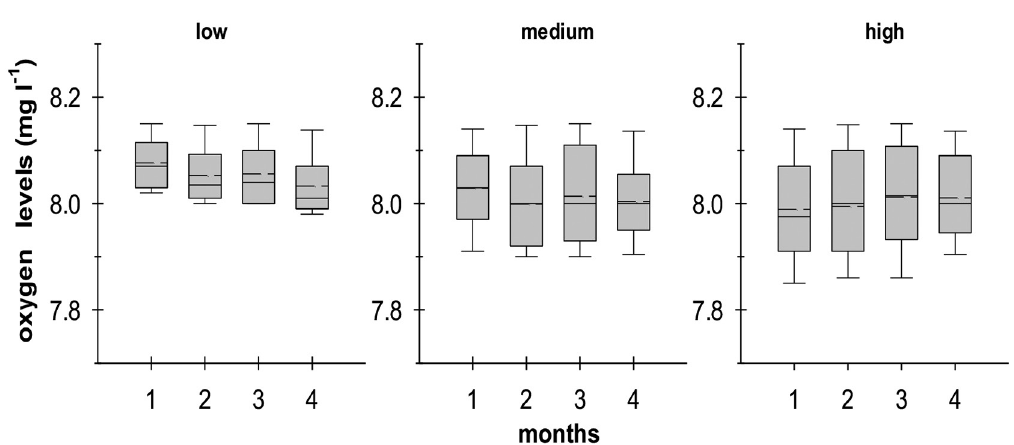
Fig. 3. – Dissolved oxygen concentrations (ppm) during the study at the three densities tested (low, medium and high).